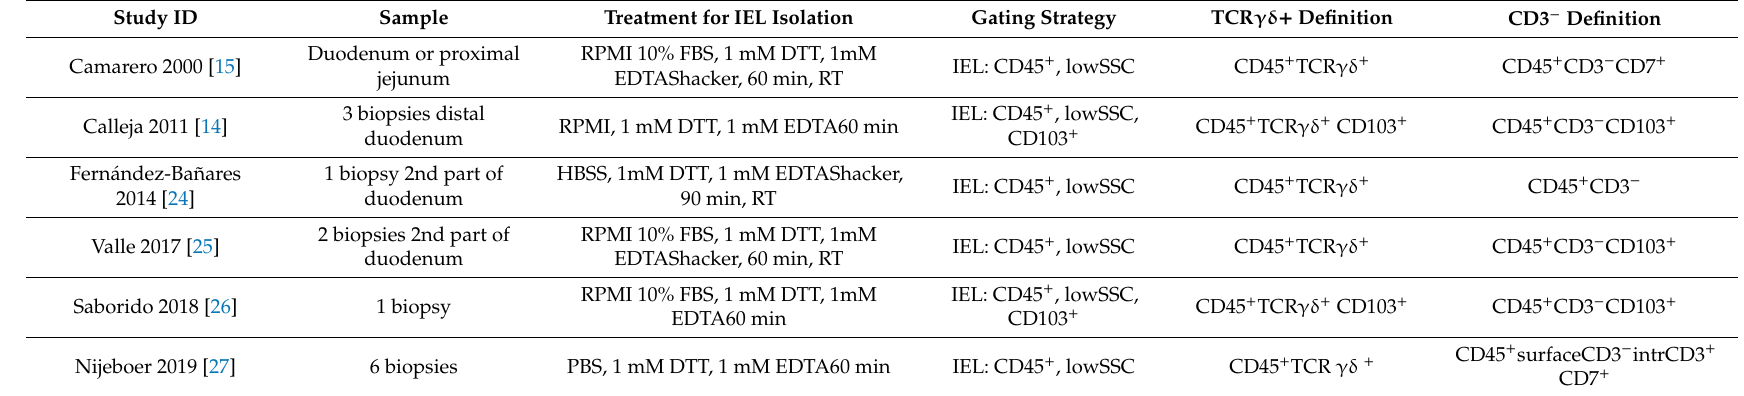
Table 2. Summary of flow cytometry technique characteristics in selected